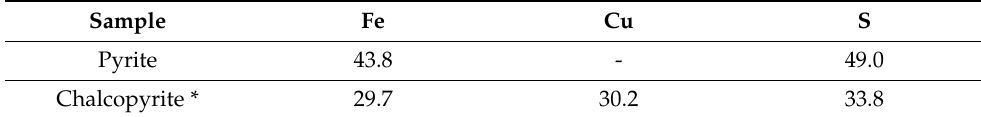
Table 1. Chemical composition of the analyzed minerals